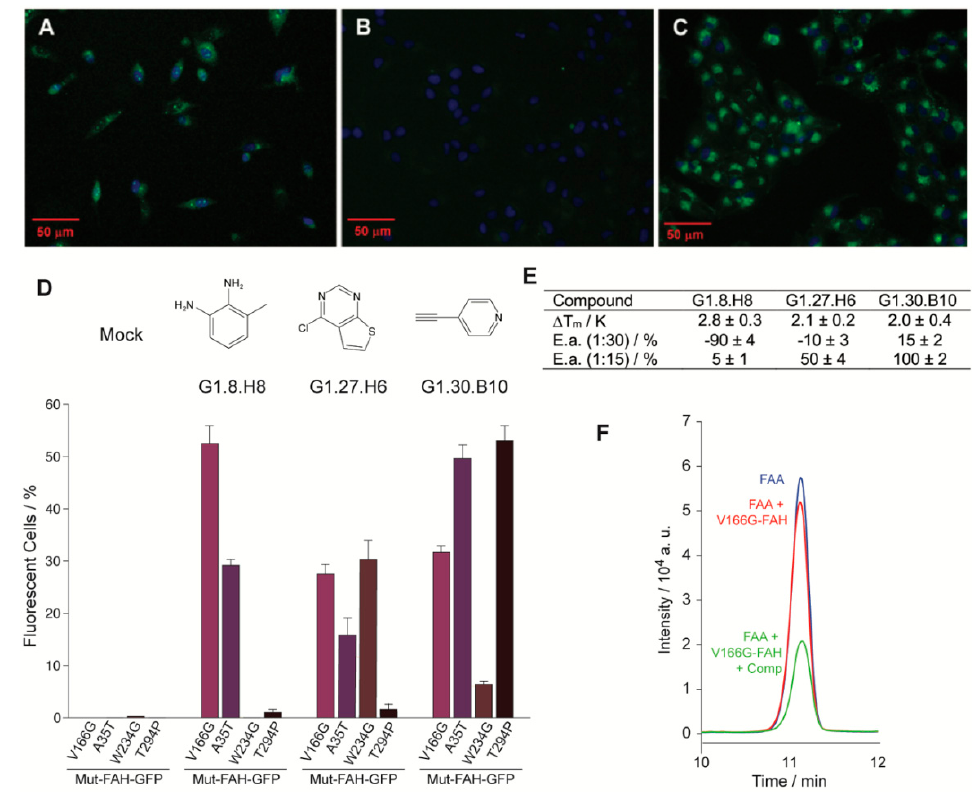
Figure 2. Eukaryotic and in vitro assays for a selected set of compounds. ( A – C ) Representative fluorescence microscopy images for the eukaryotic cellular assay. M1 cells incubated with ( A ) the proteasomal inhibitor MG132, ( B ) a compound of the library showing no effect on FAH homeostasis and ( C ) a compound that increases protein accumulation in the cytosol. ( D ) Percentage of positive cells for a set of selected compounds and for the four different mutant constructs under consideration: V166G-FAH-GFP, purple bars; A35T-FAH-GFP, violet bars; W234G-FAH-GFP, brown bars and T294P-FAH-GFP, black bars. ( E ) Change in the thermal stability (T m ) for the selected set of compounds and percentage of inhibition or activation as compared to the reference reaction for the set of compounds in the enzyme activity assay (E.a.), in the presence of 15 and 30 equivalents of a given compound as indicated. Error bars are obtained from triplicate measurements. ( F ) Region of the HPLC chromatogram corresponding to the fumaryl acetoacetate (FAA) elution. Legend: control experiment without enzyme (blue line), enzymatic reaction (red line), enzymatic reaction in the presence of compound (green